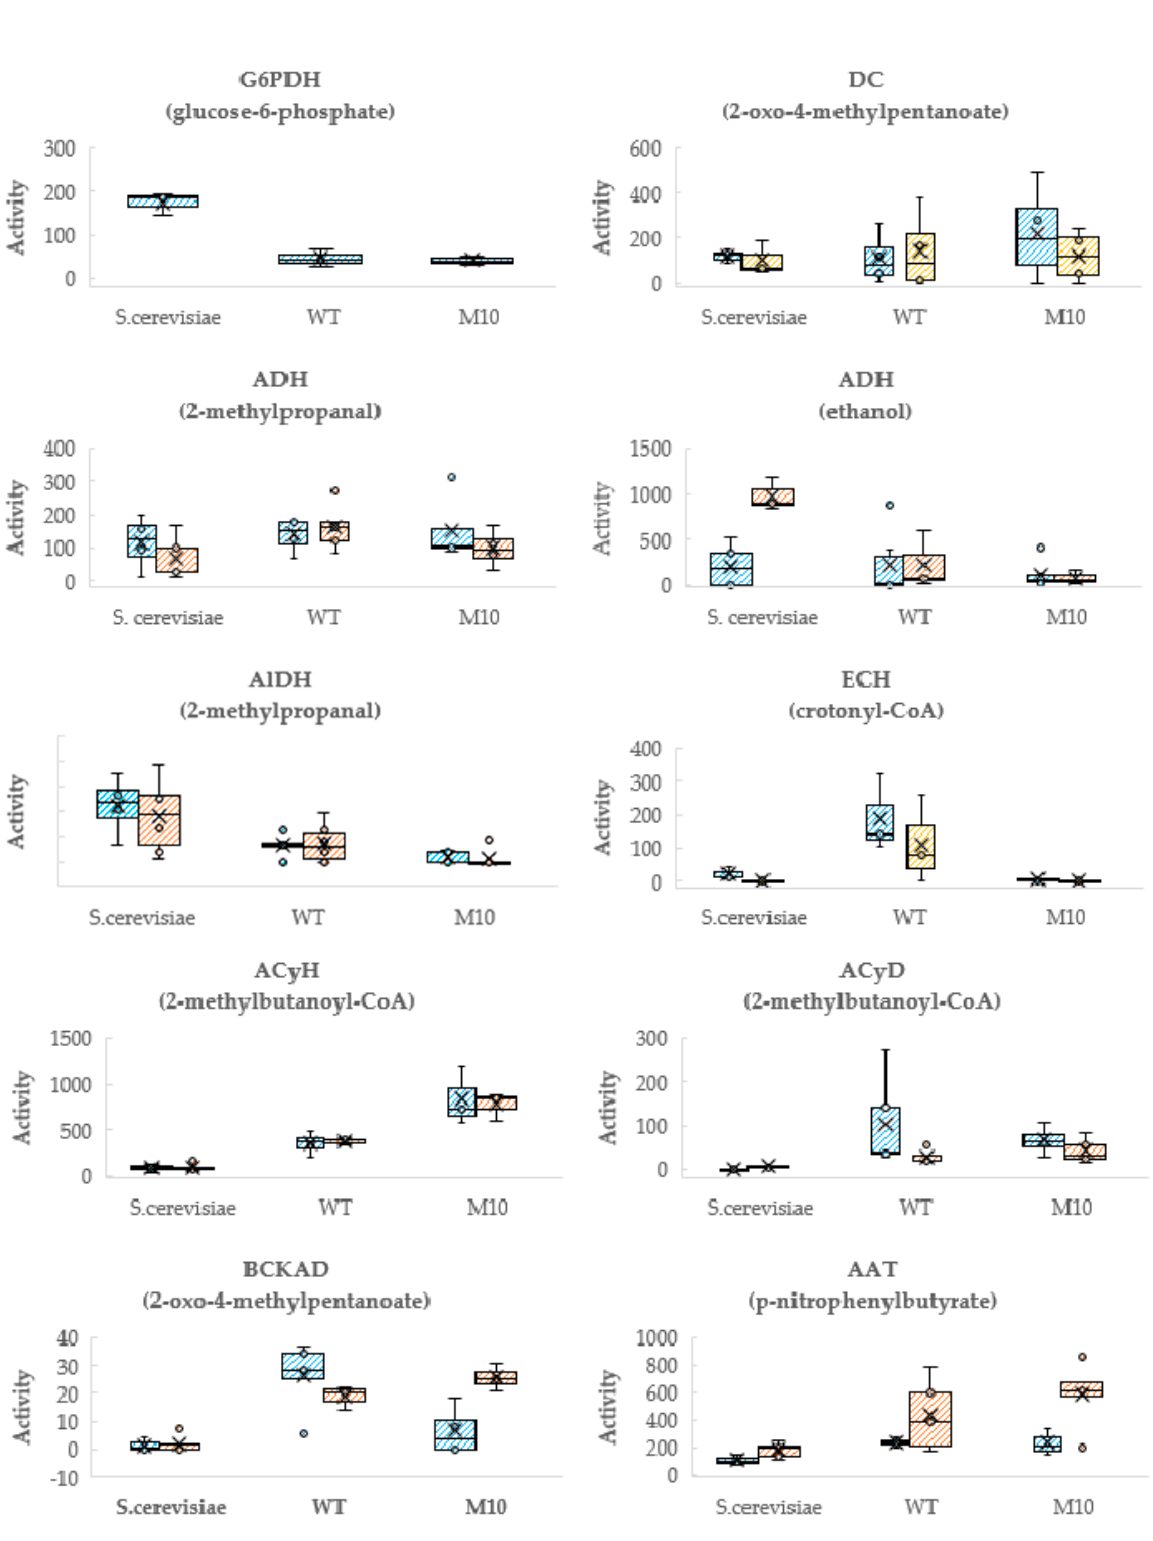
Figure 7. Activities of main enzymes involved in branched amino acids catabolism by the Ehrlich and the β -oxidation pathways in crude extract of the yeast S. cerevisiae, in the wild type of S. suaveolens (WT) and its mutant M10 cultivated in growth on YNB-Glc (blue) or YNB-Glc-Ile (orange) media. *Enzymatic activities expressed in nmol.min − 1 .mg protein − 1 were measured in triplicate and value were represented as Box-plot. Values of each replicate in an a assay is represented as a “o”, the mean value as a “ Χ ”. and median values as the bar through the plot. Abbreviation: ADH: alcohol dehydrogenase; ACyD: acyl-CoA dehydrogenase-FAD dependent; ACyH: acyl-CoA hydrolase; AlDH: aldehyde dehydrogenase; BCKAD: branched-chain α -ketoacid dehydrogenase; DC: decarboxylase; ECH: enoyl-CoA hydratase; AAT: amino acid esterase.